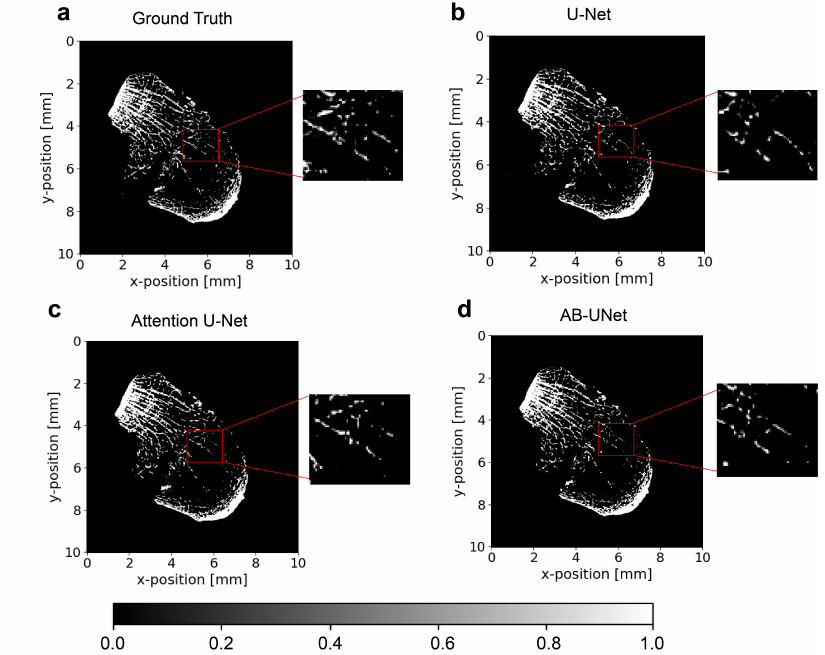
Figure 5. The example of performance comparison based on different convolution neural network (CNN) architectures: ( a ) Ground Truth, ( b ) U-Net, ( c ) Attention U-Net and ( d ) AB-U-Net. A red rectangle area is selected and zoomed to intuitively compare reconstruction effects for the complex bone